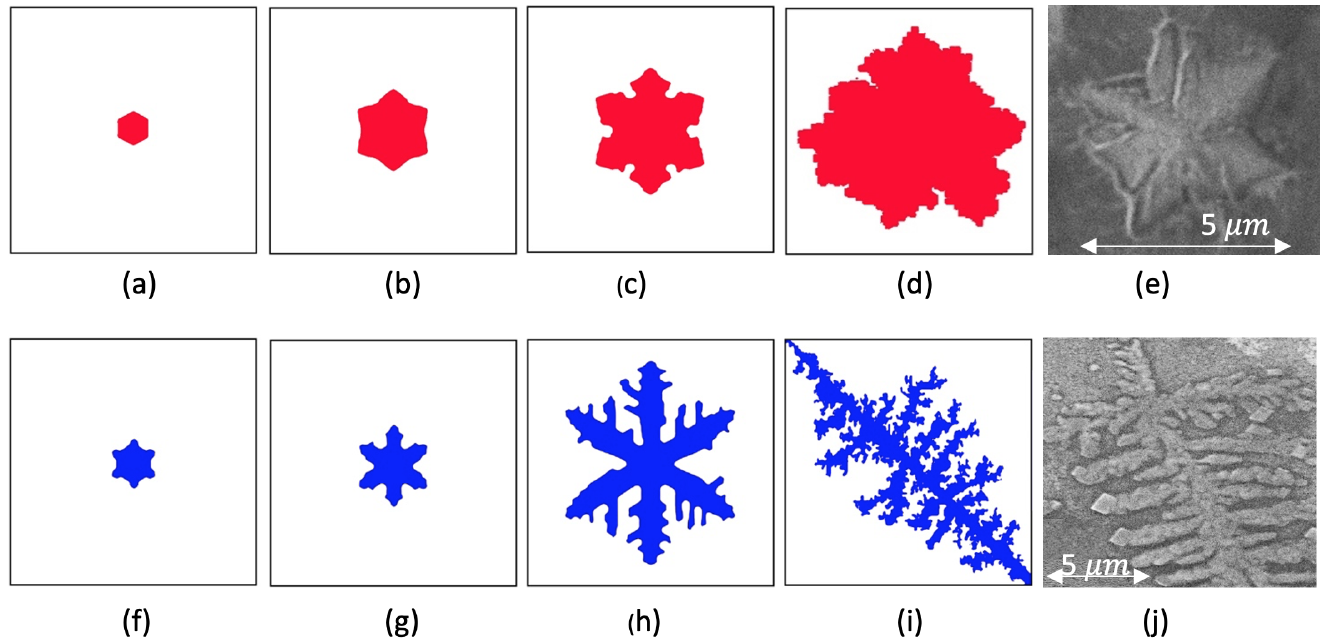
Figure 3. The calculation results and their comparison with real detected clusters: the top panel shows the dendrite snowflake generation at K = 1.2; δ = 0.050; j = 6;and θ = 1/2 π , S = 1: t = 100 ( a ), t = 300 ( b ), t = 1000 ( c ), and t = 3500 ( d ) and, corresponding to this model growth, the SEM image of a snowflake cluster formation on ( e ); the bottom panel shows dendrite star generation at K = 1.6; δ = 0.040; j = 6;and θ = 1/2 π , S = 1: t = 100 ( f ), t = 300 ( g ), t = 1000 ( h ), and t = 3500 ( i ) and, corresponding to this model growth, the SEM image of a star cluster on ( j